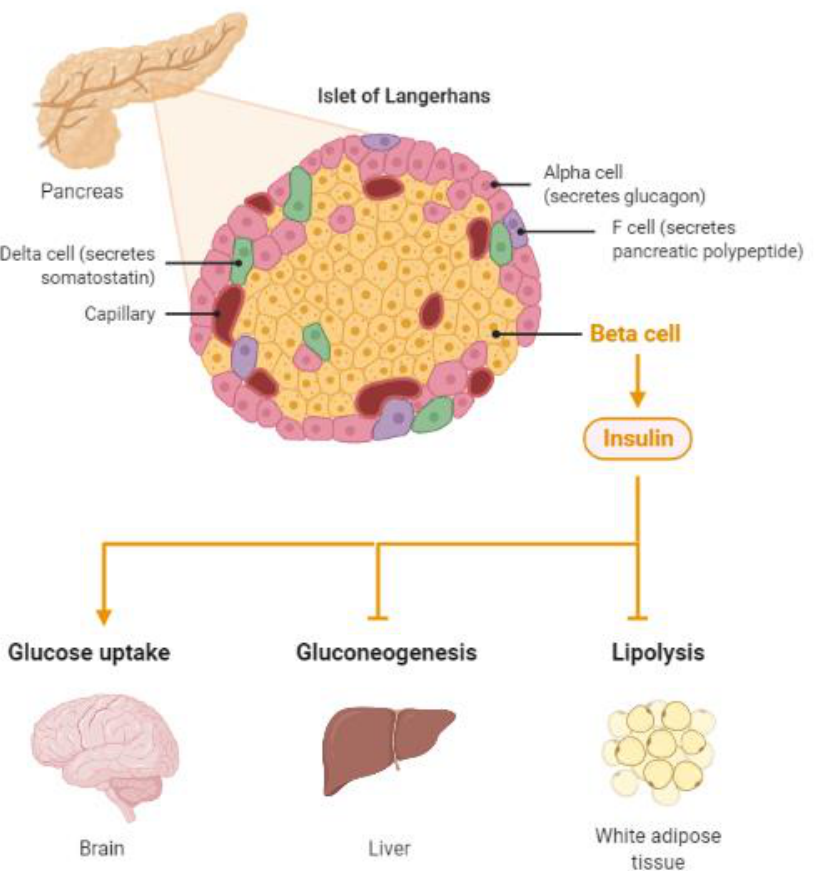
Figure 1. Insulin, a protein secreted by the pancreas, plays a major role in energy homeostasis of the body. Insulin pathologies are directly involved in the development of diabetes and Alzheimer’s disease (Created by BioRender.com, accessed on 23 August 2021).